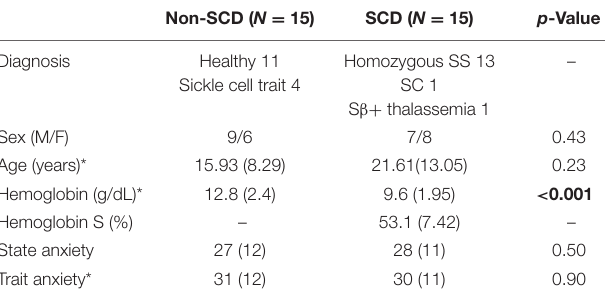
TABLE 1 | Subject characteristics and hematological